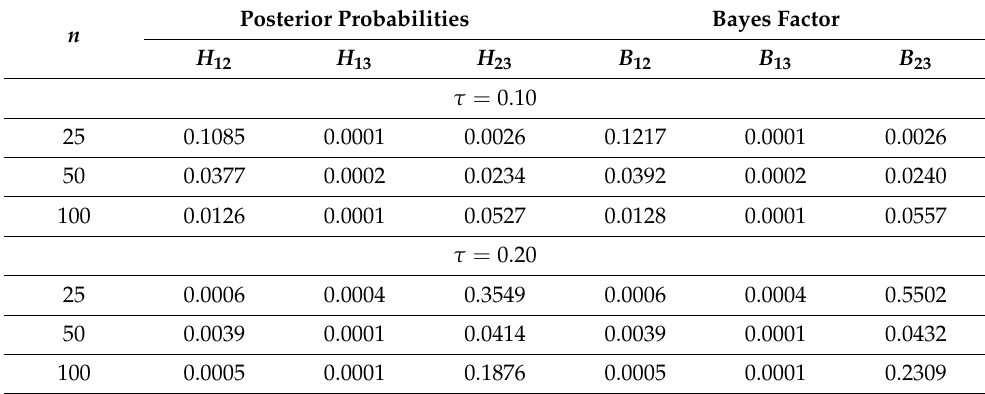
Table 4. Posterior probabilities and resultant Bayes factors associated with competing hypothesis.